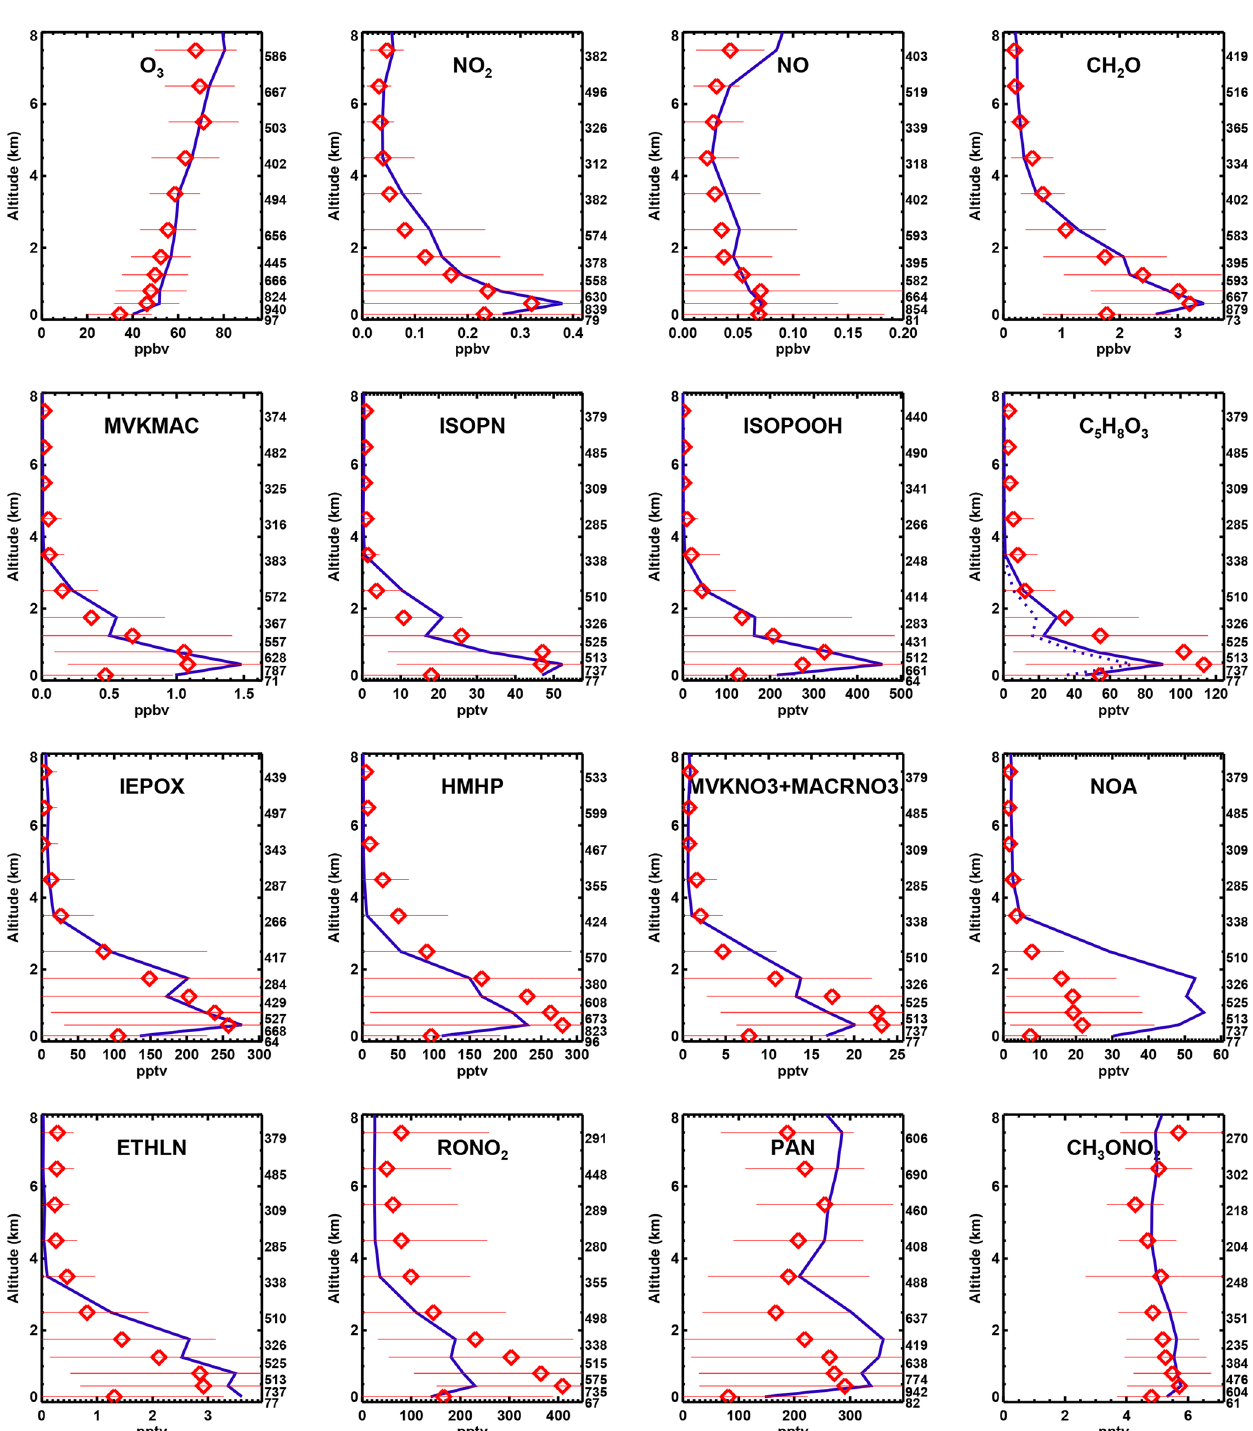
Figure 9. Observed (red symbols) and modelled (black lines) mean profiles of ozone, NO 2 , NO, and major VOC oxidation products over North America during the SEAC 4 RS campaign. The number of measurements per altitude bin is indicated on the right for each plot. The vertical bin interfaces are 0, 0.3, 0.6, 1, 1.5km, and from 2 to 8km by 1km. The horizontal lines indicate the standard deviation of the measurements within each vertical bin. MVKMAC stands for the sum MVK + MACR + 0 . 44ISOPOOH. Both the modelled HPALD (dotted line) and HPALD + ICHE (solid line) are shown in the C 5 H 8 O 3